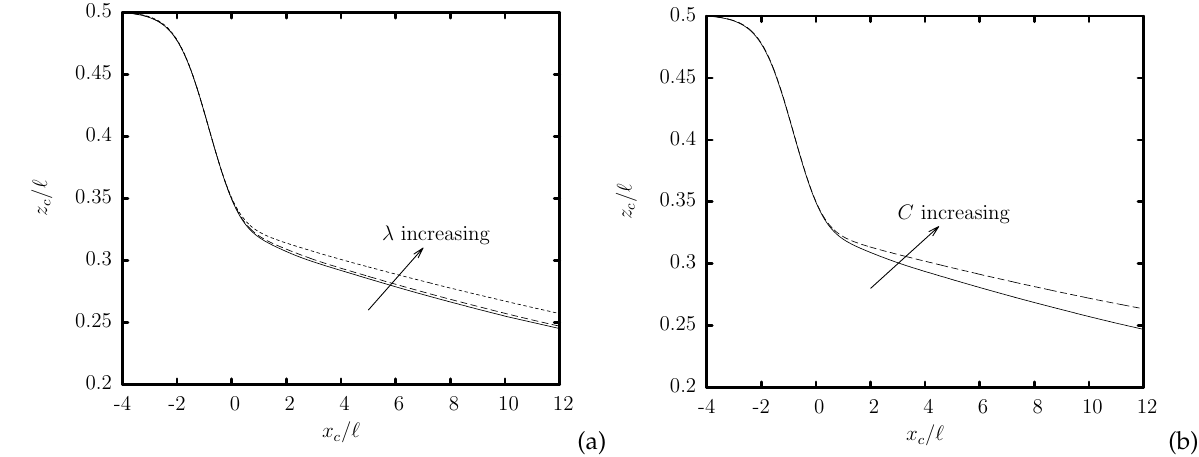
Figure 9. The capsule centroid z c as a function of the centroid x c , for a Skalak capsule with a / (cid:96) = 0.8, Ca = 0.1 and z 0 c / (cid:96) = 0.5. ( a ) The viscosity ratio is λ = 0.1,1 or 5, and C = 1. ( b ) The membrane stiffness is C = 1,2 and λ =